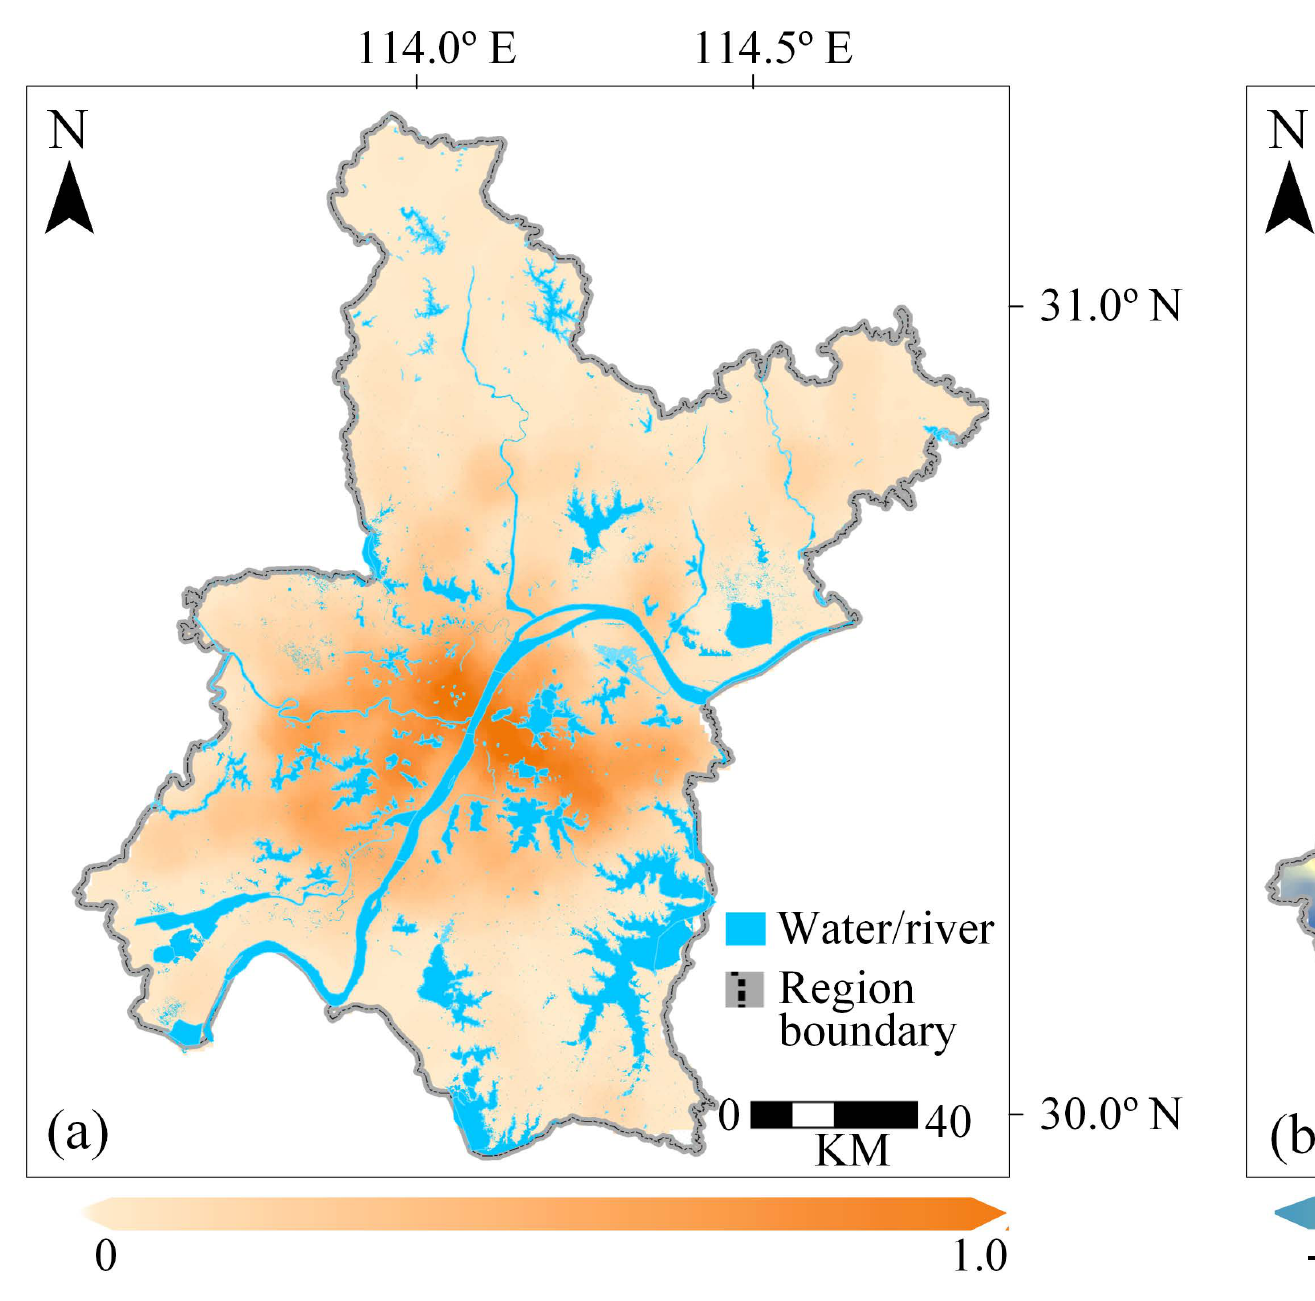
Figure 9. Road density ( a ) and the coe ffi cient for percentage of landscape (PLAND, ( b ) and aggregation index (AI, ( c )) from geographically weighted regression